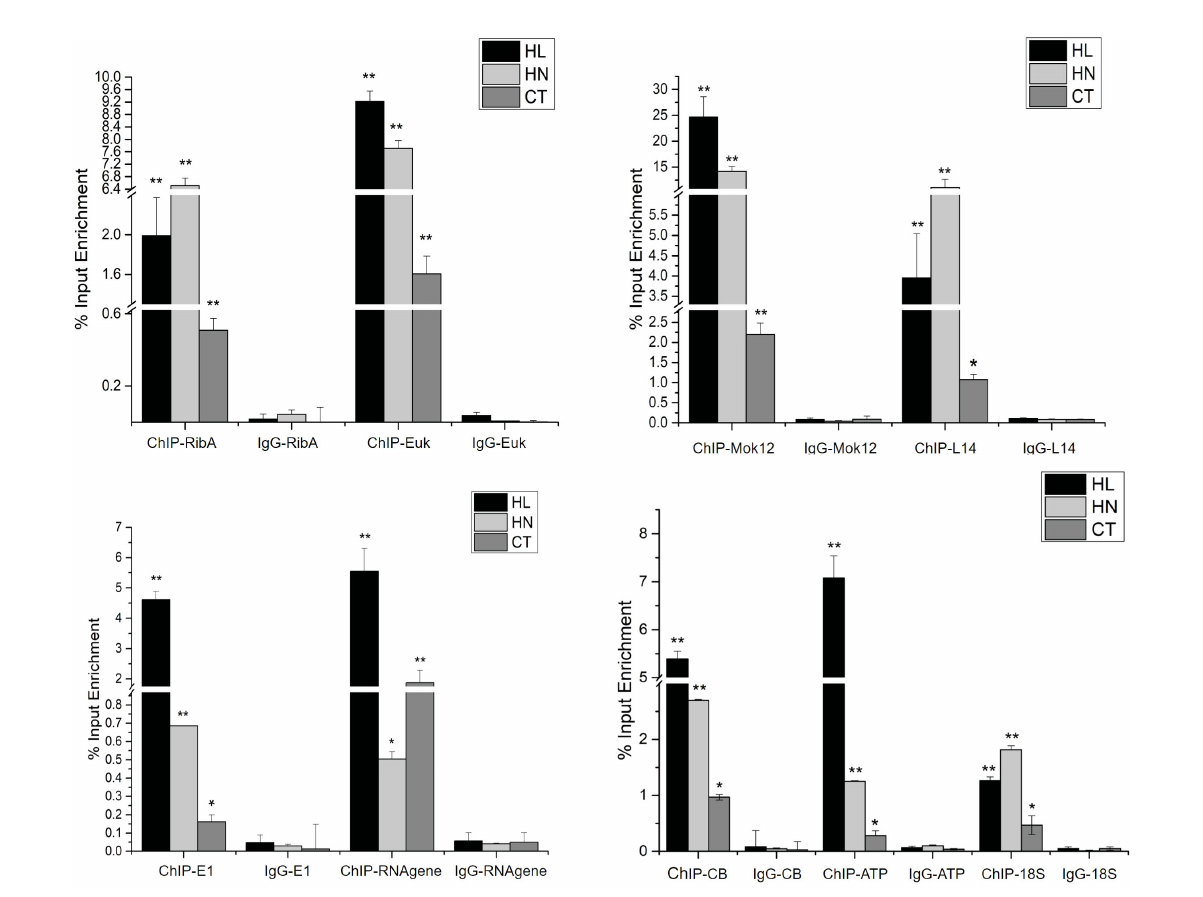
FIGURE 4 The result of ChIP-qPCR under high light (HL), high nitrogen (HN), and normal (CT) conditions. IP DNA was the experimental group and IgG DNA was the negative control group. Each column is the mean of three independent experiments. Signi fi cant differences are indicated by asterisks (** p < 0.01; * p <